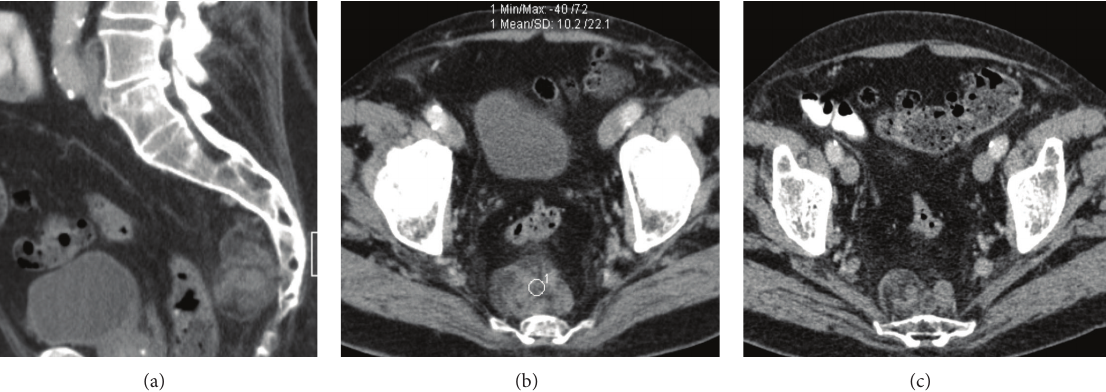
Figure 1: 84-year-old male with presacral myelolipoma. Sagittal (a) and axial ((b), (c)) contrast-enhanced CT images show the presacral mass, spanning from S3 to S5. It presented lobulated contours and a heterogeneous appearance, due to an admixture of soft-tissue and fat elements. The latter had attenuation values of about − 40HU. The mass was located in the retrorectal space and adhered to the sacrum, posteriorly.